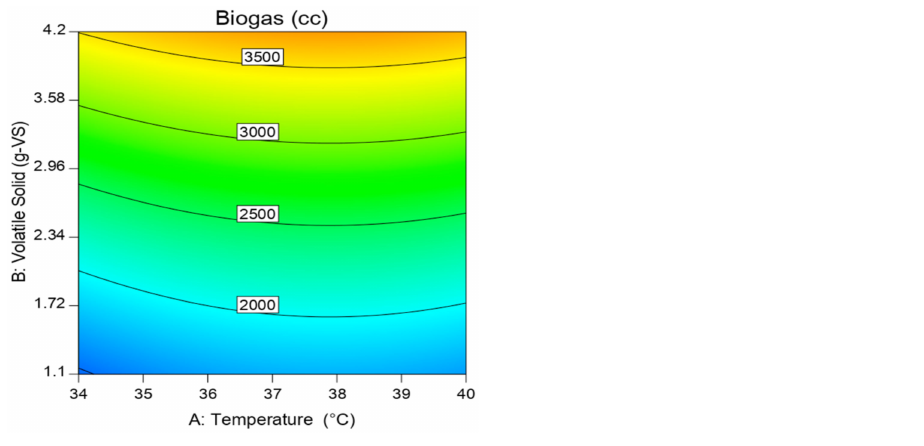
Figure 7. Contour plot views the effect of Temperature and Volatile solid on Biogas volume at sludge quantity of 37.5%.